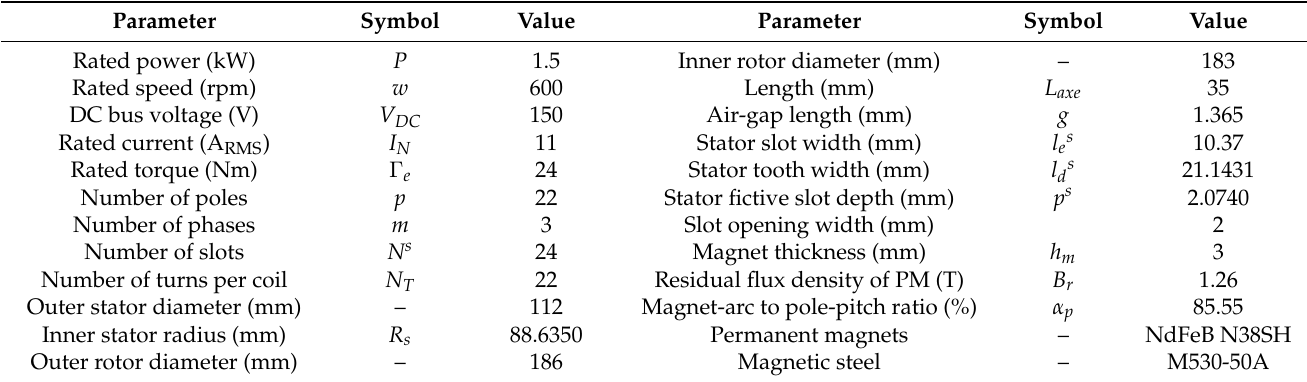
Figure 1. The model of the double-layer fractional-slot concentrated-wound ER-PMSM. Table 1. ER-PMSM parameters.